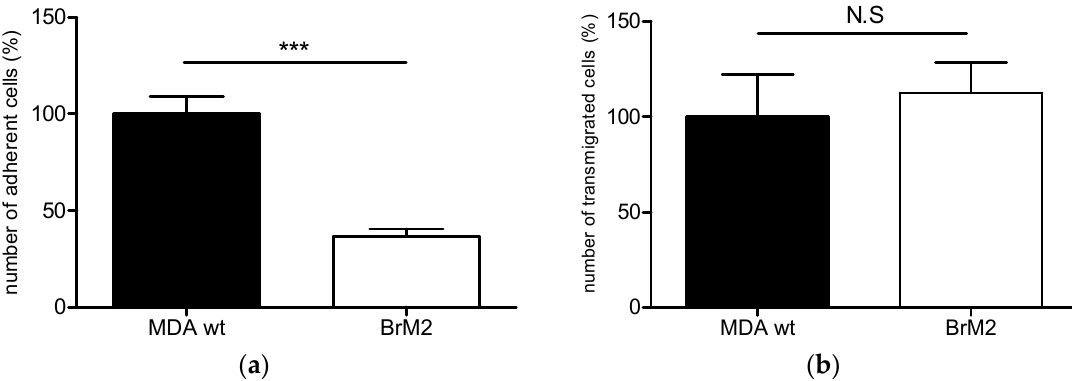
Figure 1. Adhesion ( a ); and transmigration ( b ) of MDA-MB-231 wild type (wt) and BrM2 breast cancer cell lines on the human BLECs model. The number of adherent or transmigrated MDA-MB-231 wt cells was set up to 100% and equal to, respectively, 579 and 98 cells. Results are the mean in triplicate, and representative of two independent experiments N.S: not significant; *** p < 0.001.